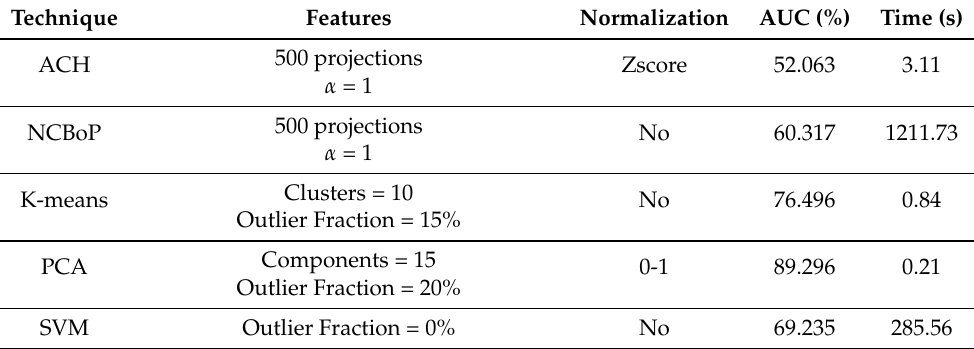
Table 1. Best AUC results for intrusion detection attacks for each